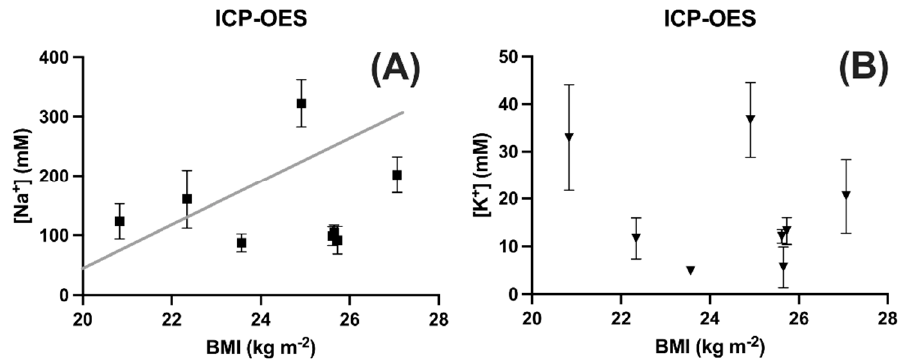
Figure 4. Correlation between body mass index (BMI) and sweat sodium ( A ) and potassium ( B ) ion level obtained via ICP-OES. The data are displayed as the mean ± SD obtained during the 30 min course for drinking purified water. The straight line in ( A ) is just a guide for the eye, not from a linear fitting.